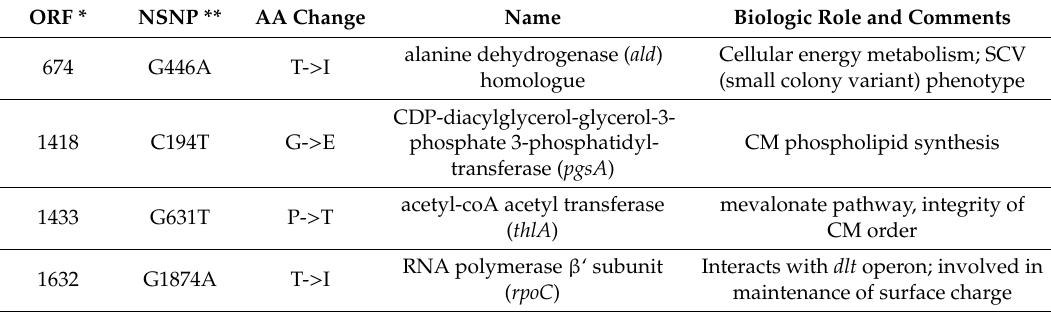
Table 4. Potential candidate genes for mediating DAP-R in S. mitis-oralis SF100